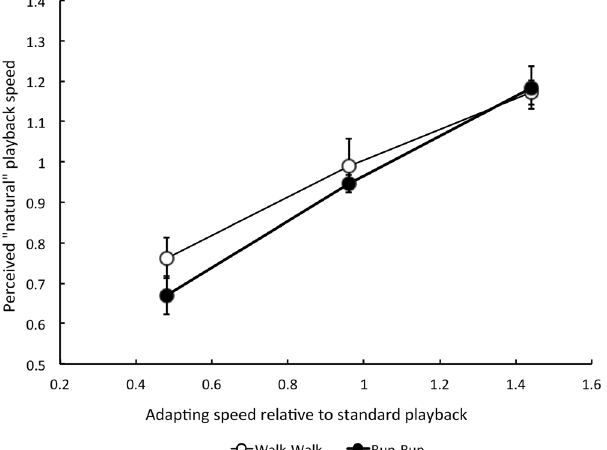
Figure 1. Results of Experiments 1 and 2, showing the playback speed at which locomotion appeared natural as a function of the adapting speed relative to standard playback. Open circles Data from Experiment 1 (walkers). Filled circles Data from Experiment 2 (runners). Values below 1.0 indicate that playback speed had to be slower than standard (1x) in order to appear natural. Values above 1.0 indicate that playback speed had to be faster than standard to appear natural. Each data point represents the mean 50% point (P50) of five participants ( + / − 1 SE) derived from best-fitting cumulative normal distributions applied to each participant’s response